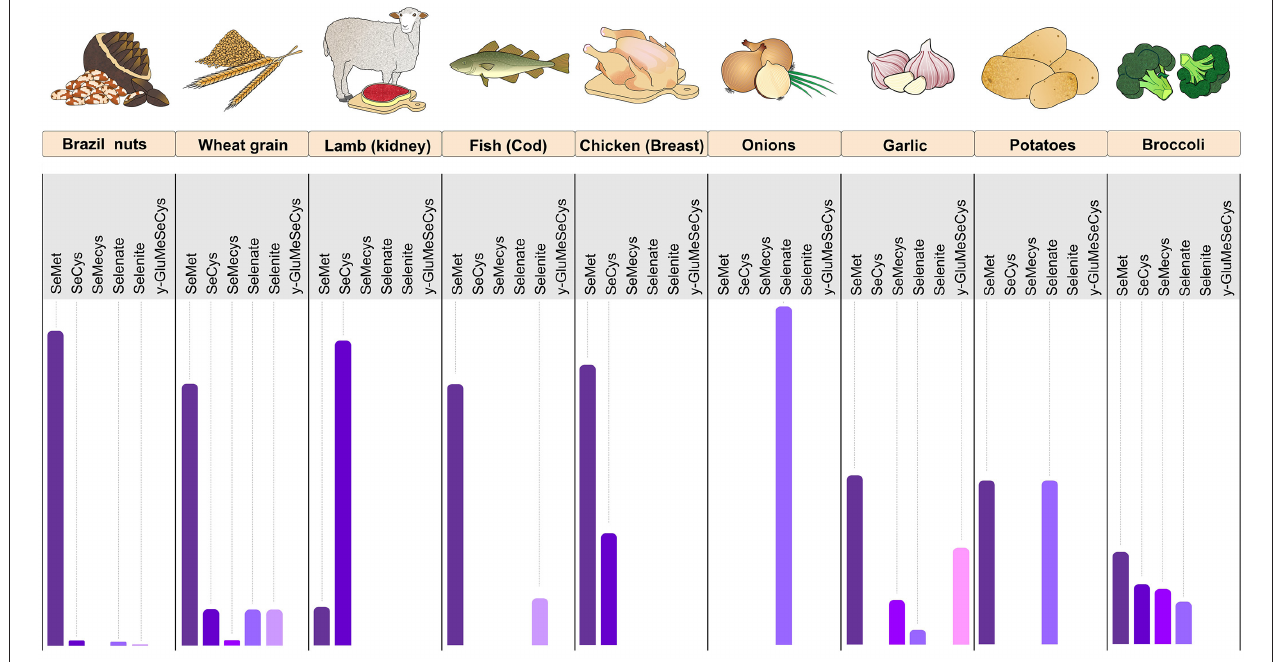
FIGURE 1 | Foods rich in Se with their relative proportions of SeMet, SeCys, SeMeCys, selenate, selenite, and γ -GluMeSeCys. The figure shows the predominance of SeMet in Brazil nuts, wheat grain, fish cod, and chicken (breast). Lamb meat (kidney) is rich in Se mainly in the SeCys form, whereas onion has Se almost exclusively in the form of selenate. Garlic, potato, and broccoli have a balanced proportion of the various forms of Se. Se, selenium; SeMet, selenomethionine; SeCys, selenocysteine; SeMeCys, selenium-methylselenocysteine; γ -GluMeSeCys, γ -glutamyl-Se-methyl-selenocysteine (Figure illustration by Francisco Irochima